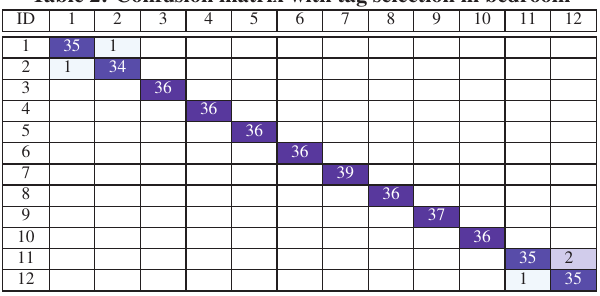
Table 2: Confusion matrix with tag selection in bedroom